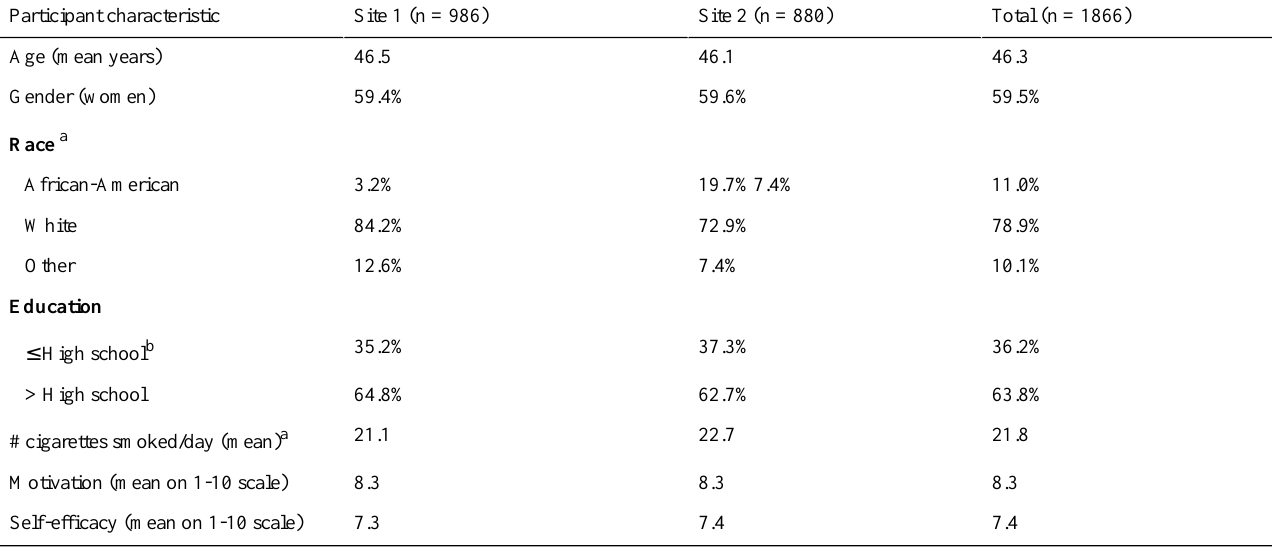
Table 1. Participant characteristics by HMO